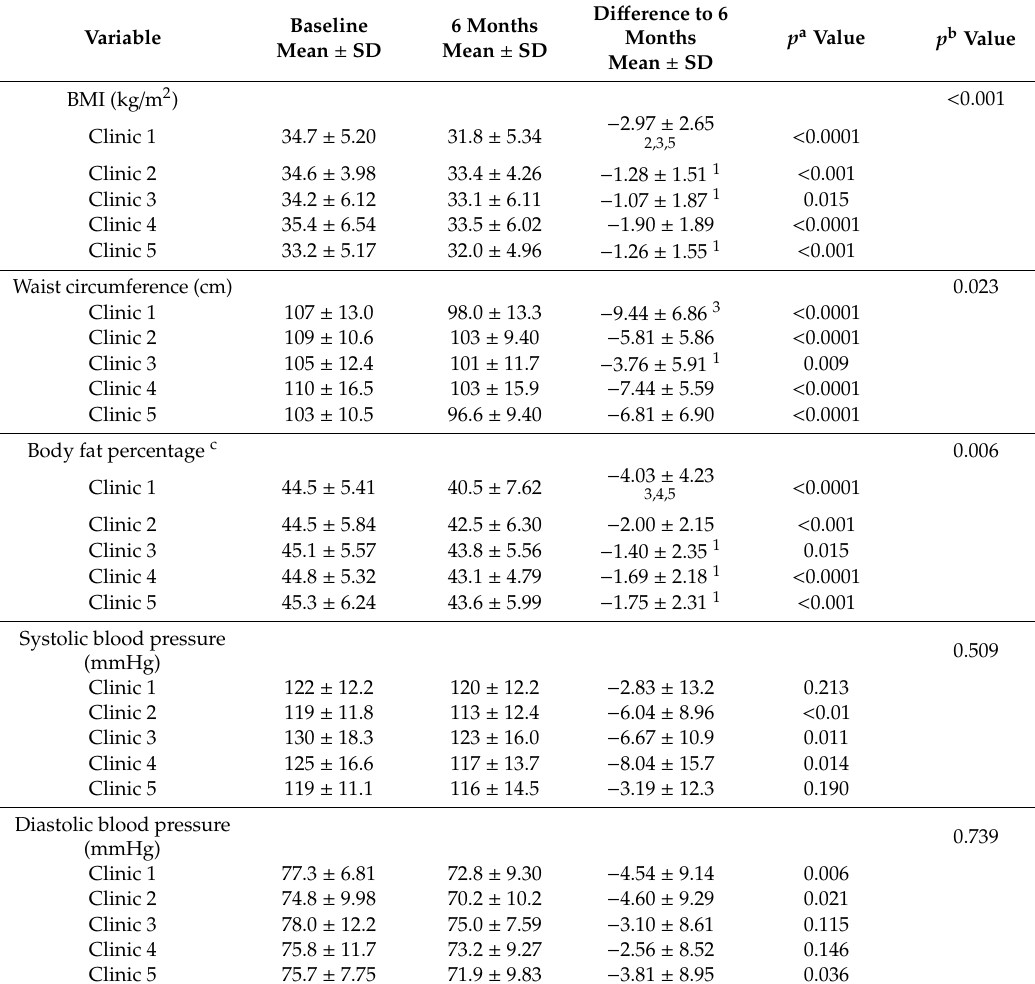
Table 3. Changes in obesity and blood pressure parameters of participants completing the 6 month intervention phase with the adapted Diabetes Prevention Program ( n =